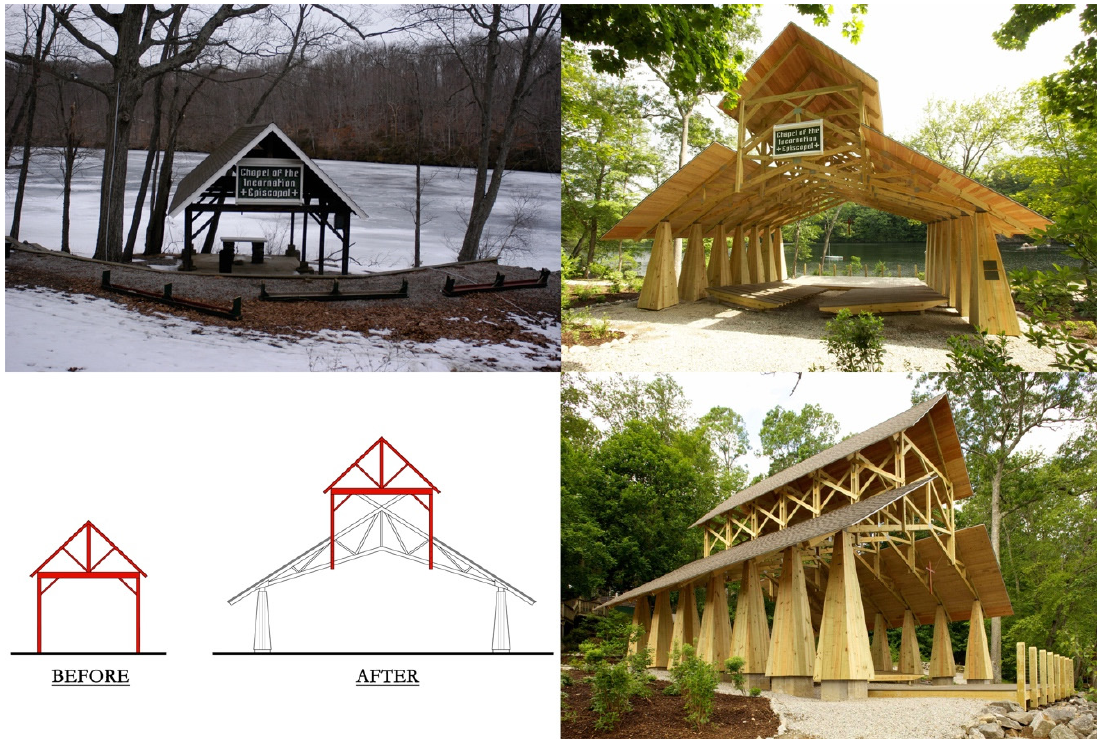
Figure 3. This new chapel uses the “Why” of history to create its form from a 50 year old place in an exquisite setting. It is now three times larger and follows its legacy and